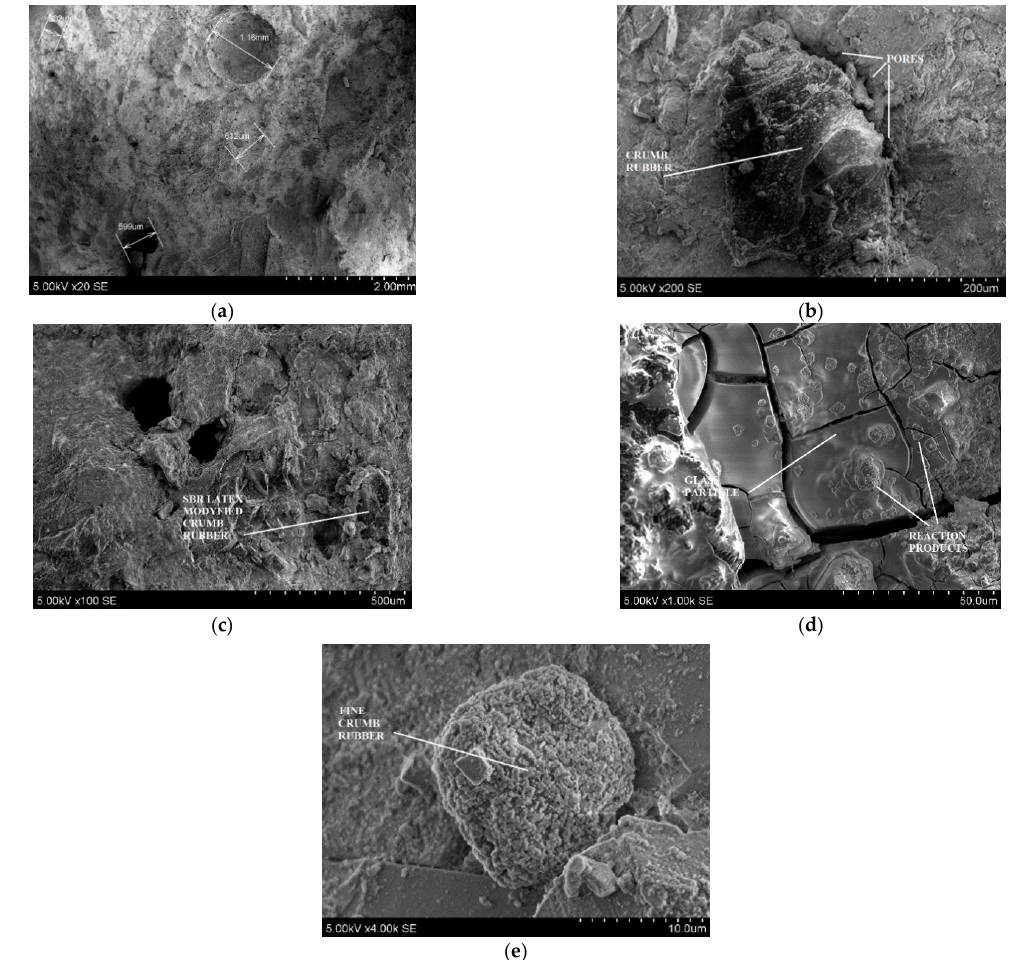
Figure 7. SEM images of concrete particles of prefabricated air bubble ( a ), crumb rubber ( b ), SBR latex modified crumb rubber ( c ), glass powder ( d ), fine crumb rubber ( e ).